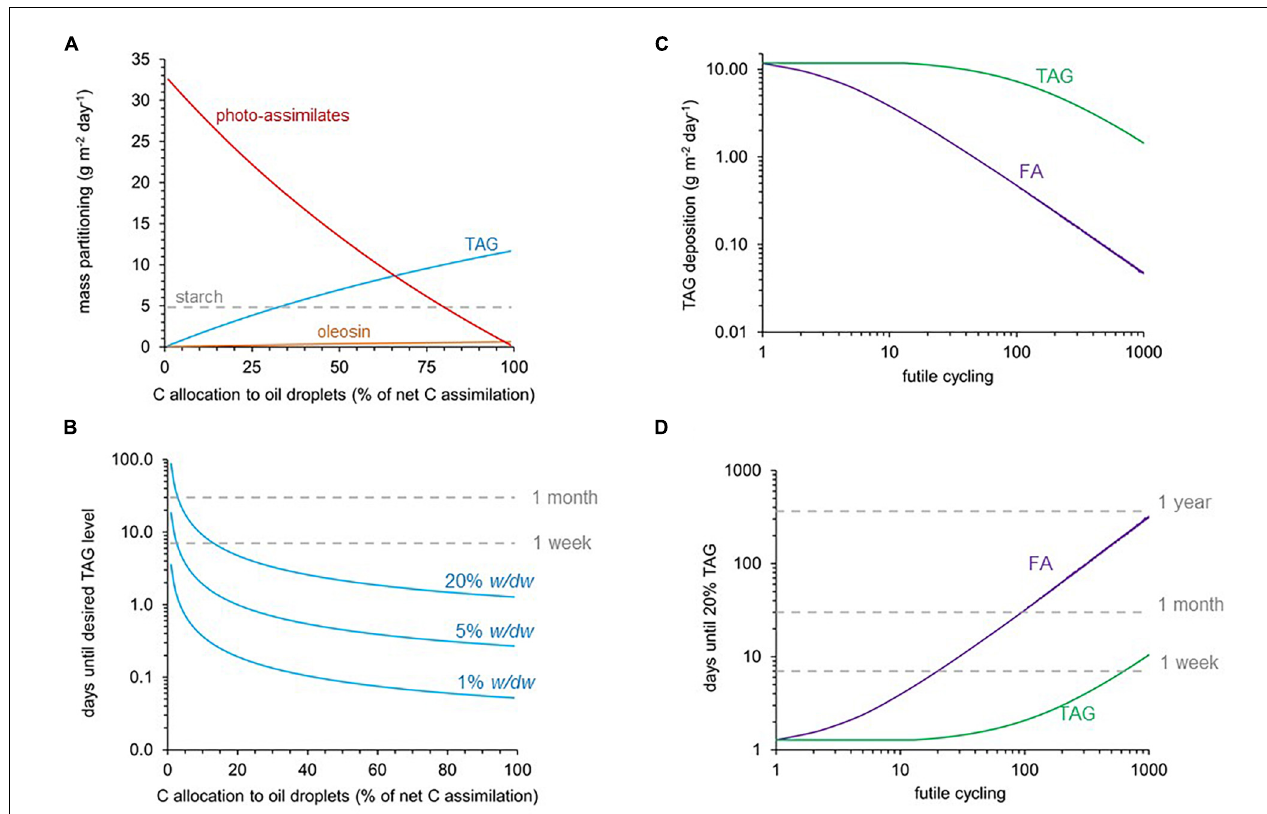
FIGURE 5 | Model simulations for TAG accumulation in mature leaves. Daily photo-assimilate export (sucrose and amino acids) and TAG accumulation was modeled for mature Sorghum bicolor leaves under full-sun exposure ( iTJC1414x4 ). See Supplementary Table 2 for main model constraints. (A) Mass partitioning of primary photo-assimilates between photo-assimilates (exported), starch (transitory), and TAG, which is deposited in the leaf with oleosin. Starch is not counted as net assimilation since it is completely degraded by night respiration activities. (B) Time period until a target level (1, 5, 20% w/dw) of TAG accumulation is reached, in dependence of the fraction of assimilated carbon being allocated to oil droplets (i.e., TAG and oleosin synthesis). The effects of TAG (purple) and FA (green) futile cycles on (C) TAG deposition and (D) the time needed to reach 20% (w/dw) TAG in leaf tissue if 100% of net photo-assimilated carbon is partitioned into oil droplets. TAG or fatty acids are synthesized up to 1,000-fold in excess over what is stored as TAG in oil droplets. Cycling units are mol TAG synthesis per mol TAG accumulated in oil droplets (TAG cycling) and mol fatty acid synthesis per mol fatty acid stored in oil droplets (FA cycling) (see section “Materials and Methods,” Equations 4,